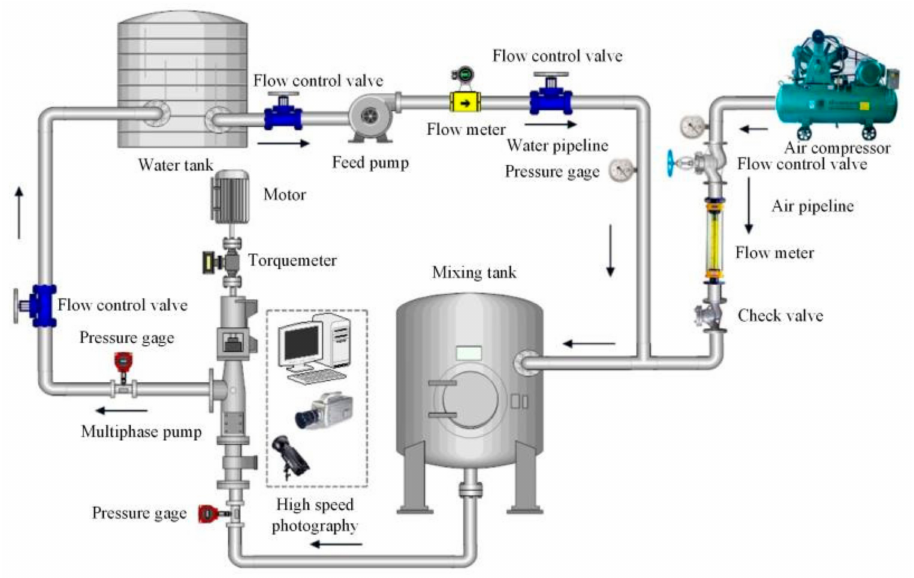
Figure 6. Schematic of the multiphase pump test rig.